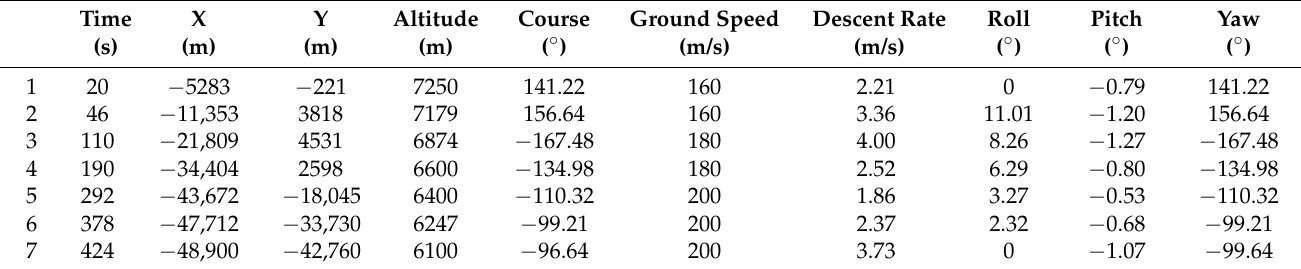
Table 4. Trajectory data for conventional simplistic